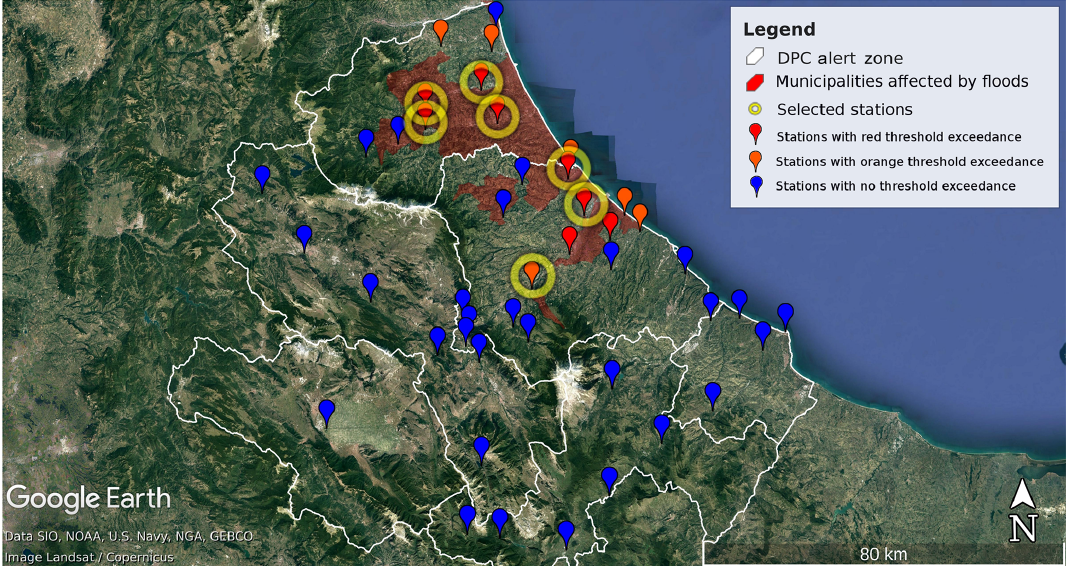
Figure 8. A map from Google Earth showing the geolocation of the hydrometric sensors over the Abruzzo region (pinpoints) colour-coded based on the warning threshold exceeded during the event. Yellow-circled sensors represents the subgroup where the analysis at station level is presented. The red areas correspond to the municipalities affected by flood.